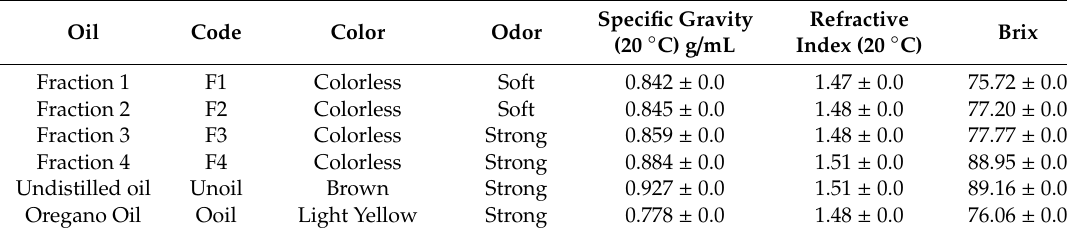
Table 1. Physicochemical characteristics of the oil fraction.